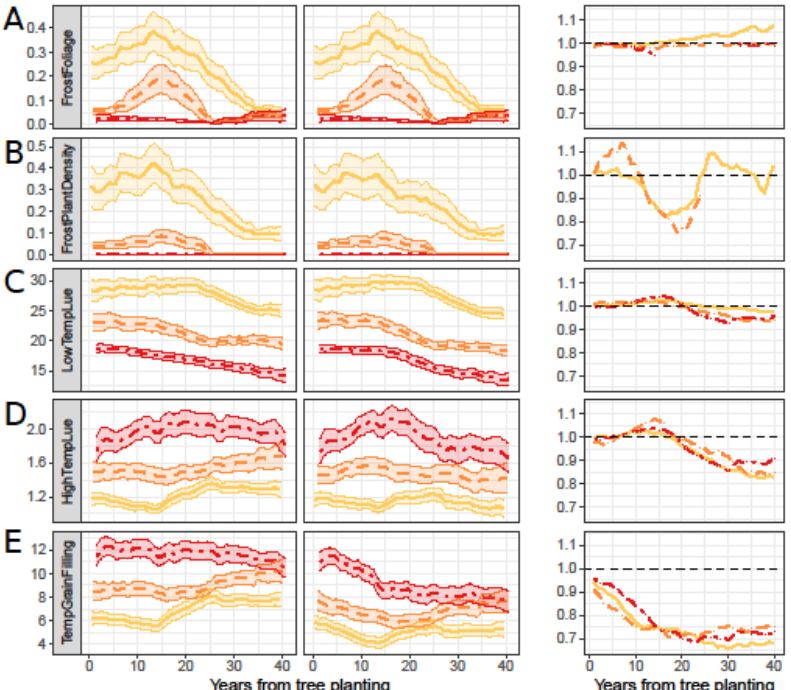
Figure 3. Crop thermal stress indices in agriculture ( left ), agroforestry ( middle ), and relative values (AF/A, right ), in Past (yellow), Present (orange), and Future (red) climates. To present only the most interesting relative stress values, those resulting from absolute values lower than 5% the maximum stress value are not shown. Thermal stresses were: FrostFoliage for the effect of frost on foliage ( A ), FrostPlantDensity for the effect of frost on plant density ( B ), HighTempLUE, for the effect of high temperature on LUE ( C ), LowTempLUE for the effect of low temperature on LUE ( D ), and TempGrainFilling for the effect of high temperature on grain filling ( E ). Each scenario is represented by averaging 11 repetitions, while using a moving window of 11 years. Vertical lines represent the 95% confidence intervals.